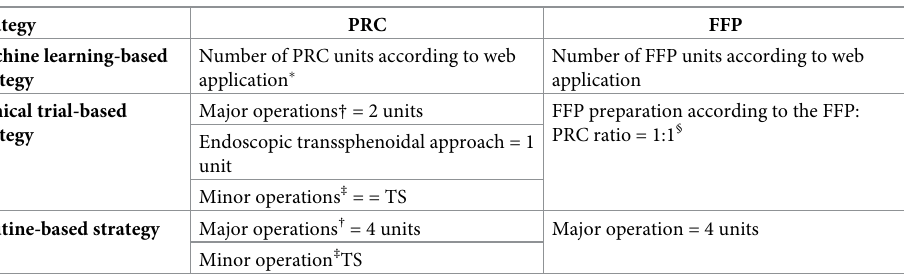
Table 1. The strategy of preoperative blood preparation.